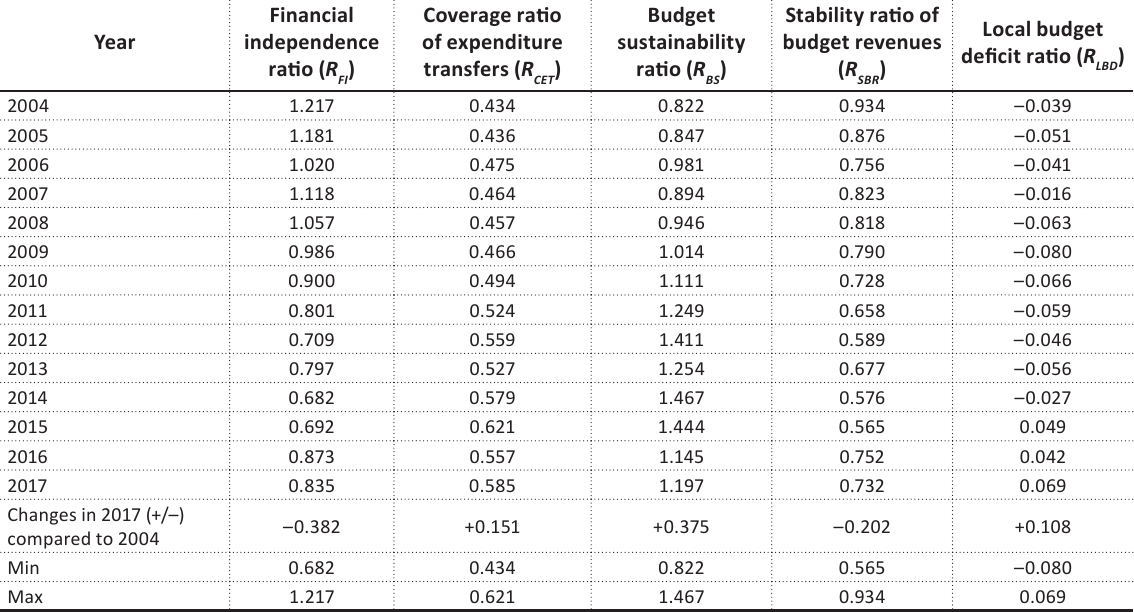
Table 4. Indicators of decentralization of intergovernmental relations Source: Authors’ calculations based on data from CASE Ukraine